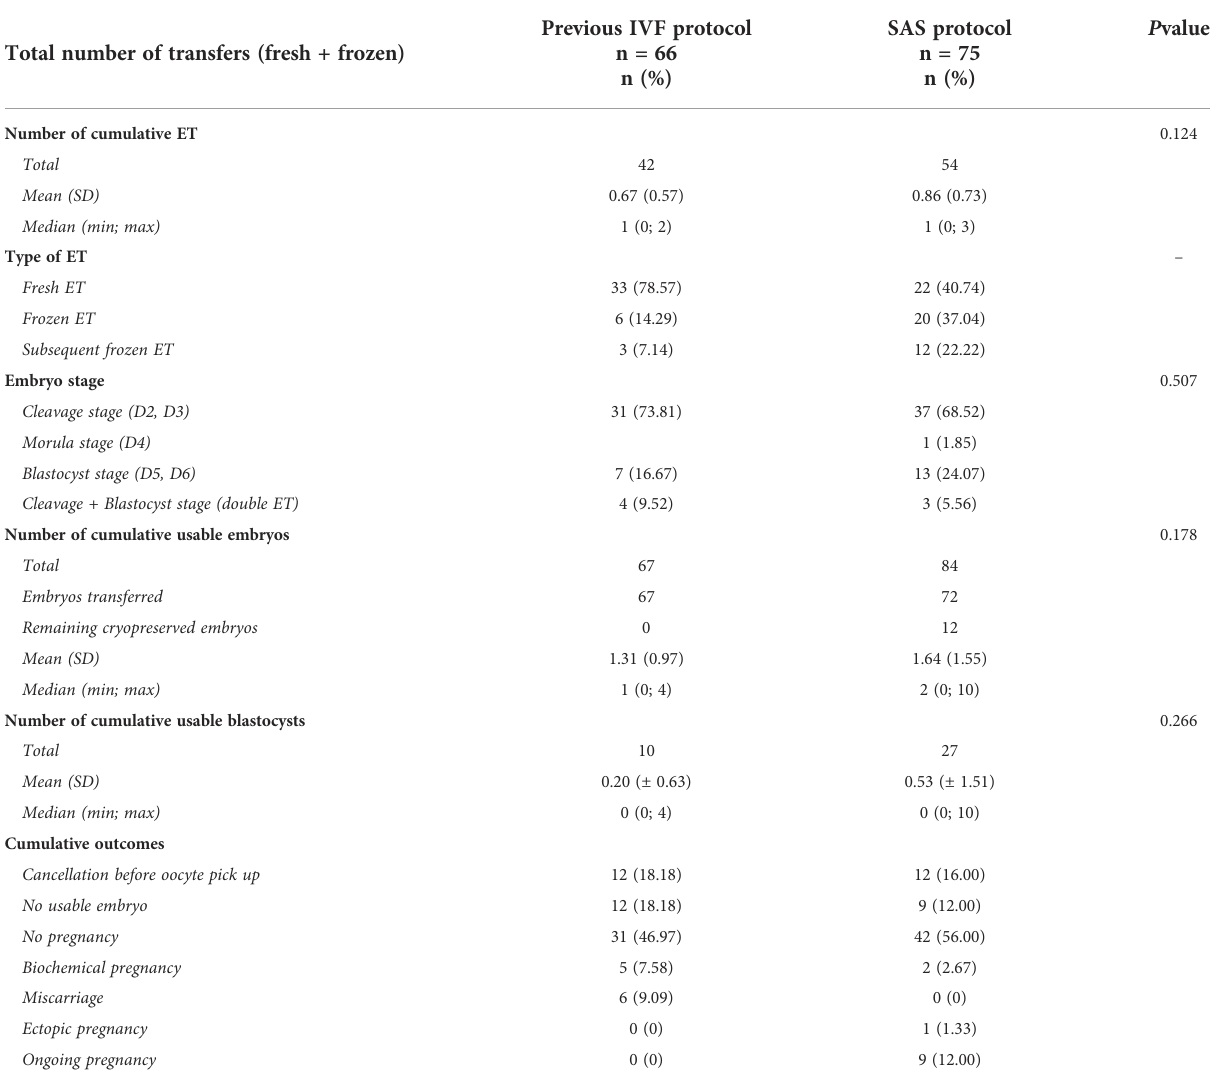
TABLE 3 Cumulative IVF